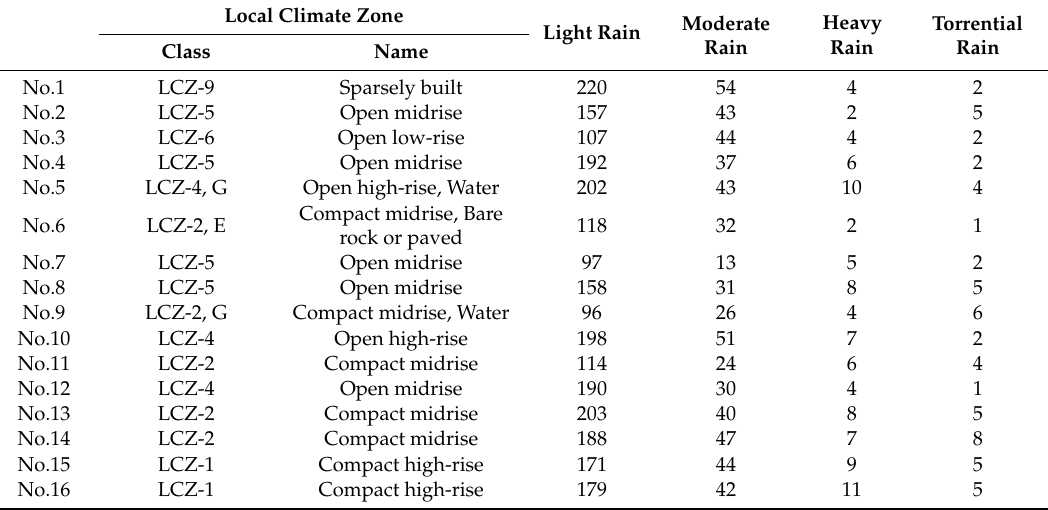
Table 2. Hours of light rain, moderate rain, heavy rain and torrential rain in 2018 at each station. Local Climate Zone Light